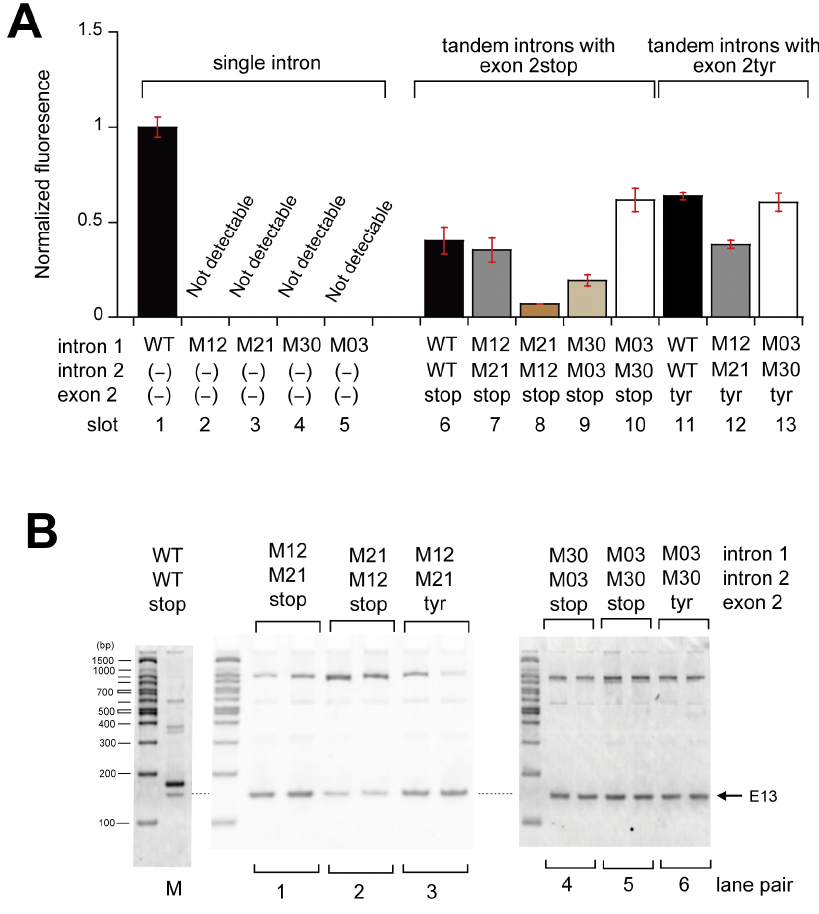
Figure 4. Exon-skipping splicing conducted by pairs of chimeric group I introns. ( A ) β-Galactosidase reporter gene assays to evaluate the splicing activities of precursors with WT, ∆P5, and four chimeric introns as well as eight precursors with two introns and a short exon (exon 2) in E. coli . ( B ) RT-PCR assays to distinguish the ligated exons (E123 or E13) including or skipping exon 2, with lengths of 174 and 150 bp, respectively.